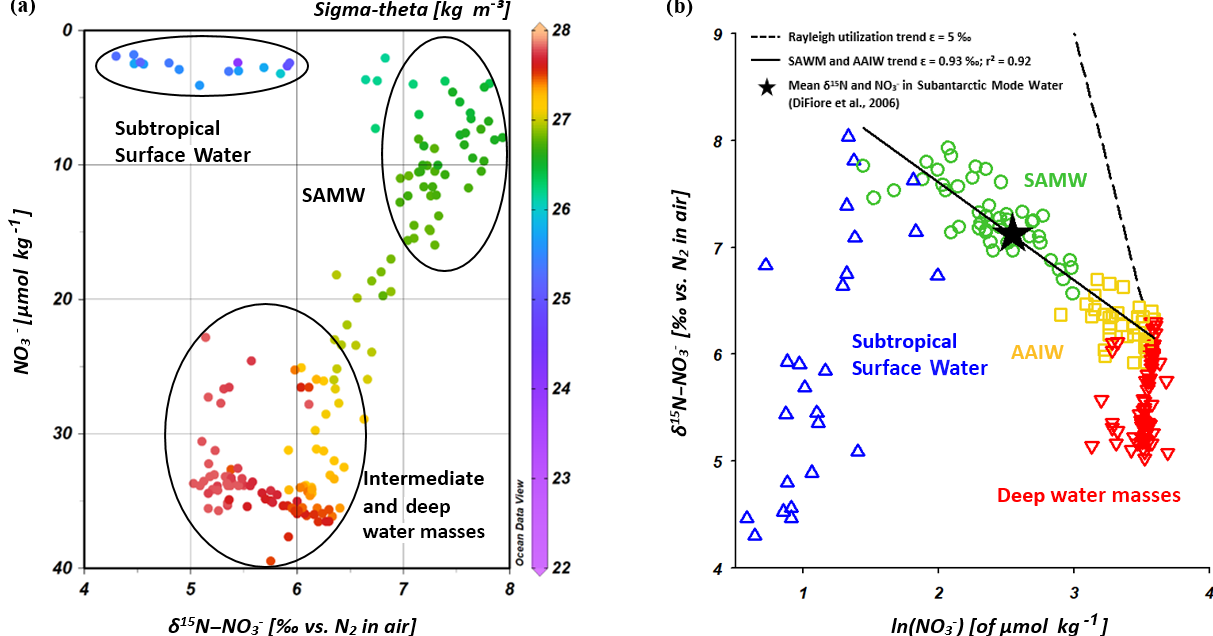
Figure 9. Nitrate concentrations vs. δ 15 N–NO − The colour code of dots in Fig. 9a indicates the potential density sigma-theta (kgm − 3 ). In Fig. 9b, data are grouped for the Subtropical Surface Water (blue), SAMW (green), AAIW (yellow) and deep water masses